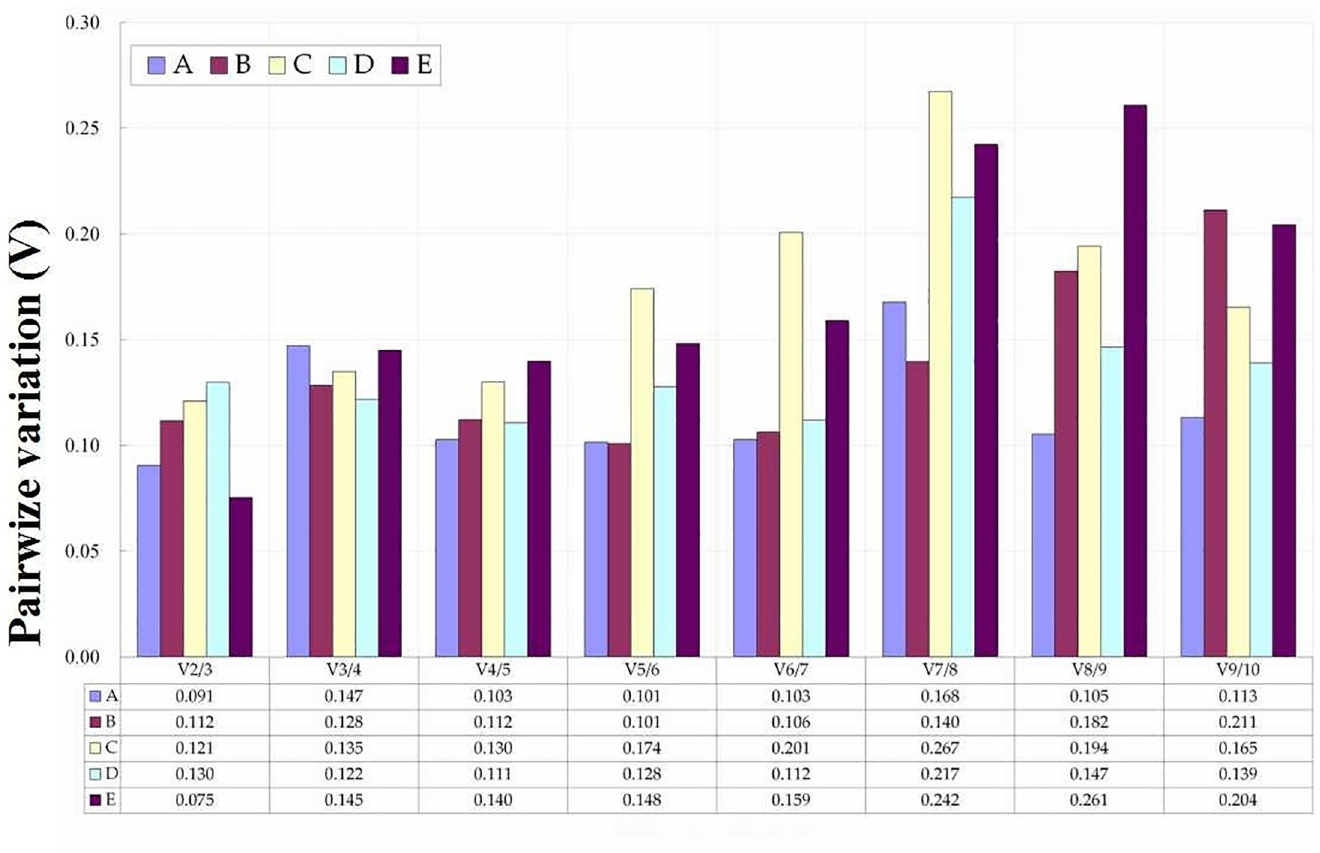
Fig 3. Pair-wise variation (Vn/n+1) calculated by geNorm to determine the minimum number of reference genes for accurate normalization in different experiment conditions. (A) different cultivars; (B) different organs of the same genotype; (C) leaves treated by three abiotic stresses; (D) roots treated by three abiotic stresses; (E) ‘leaves + roots’ treated by three abiotic